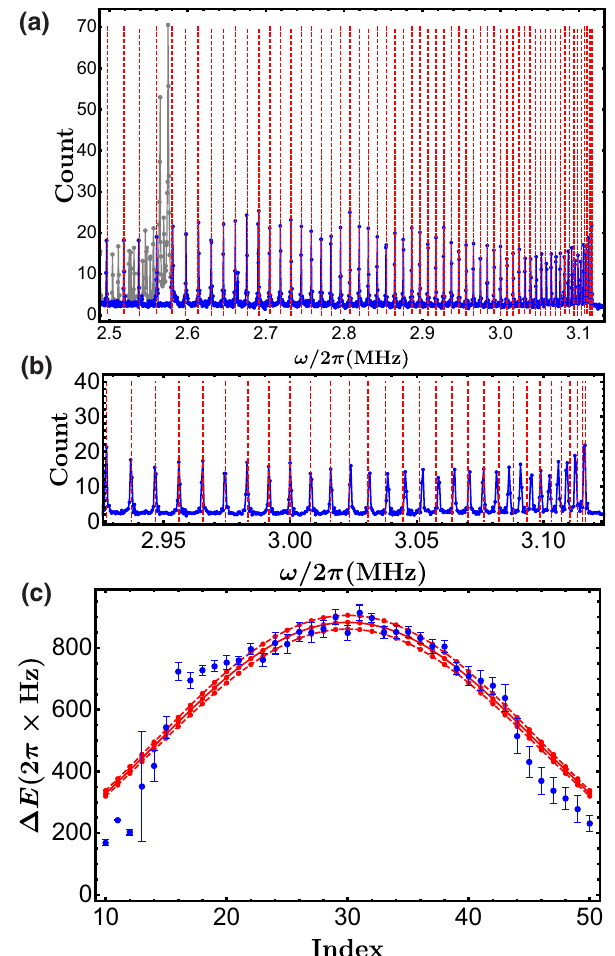
FIG. 2. Calibration of the long-range Ising coupling. (a) We scan the blue phonon sidebands for N = 61 ions (blue dots) and use them to fit the interion distances. (The gray dots are identi- fied as peaks for the transverse modes in the orthogonal direction and are not relevant to this experiment.) The red dashed lines are the fitting results under a uniform transverse trapping fre- quency ω x = 2 π × 3.1166 MHz. (b) An enlargement of the fitted phonon band at the high-frequency end. The small discrepancy can be explained by the inhomogeneity in the transverse trap- ping potential over the 207 μ m ion chain. (c) We initialize the √ 2) and drive spin chain in | ↑ x · · · ↑ x (cid:4) ( | ↑ x (cid:4) ≡ ( | ↑ z (cid:4) + | ↓ z (cid:4) )/ it with a weak oscillating transverse-field term. The resonant frequencies for individual ions are shown as the blue dots with error bars representing one standard deviation, and are compared with the theoretically computed values (red dots). The upper and lower red dashed curves represent ± 2 π × 500 Hz shift in laser detuning. Raman π/ 2 pulses are used to initialize and to measure the spin states in the σ x basis. Due to the nonuniformity of the laser intensity over the long ion chain, such pulses are inaccurate for the edge ions, thus the corresponding results are not